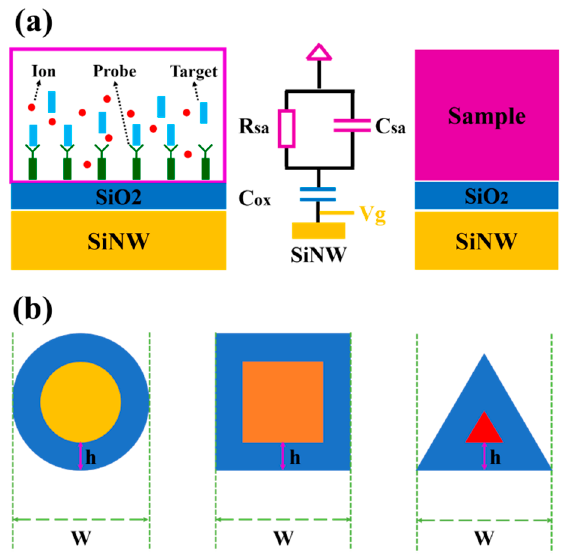
Figure 2. ( a ) The schematic of the sensitive mechanism during the process of target detection and the equivalent circuit model for SiNWs-FET sensors. ( b ) Cross-section view of the depleted area of the three types of silicon nanowire with the same depletion depth h . Table 1. The cross-sectional areas of three kinds of SiNWs-FET sensors. Cross-Sectional Areas